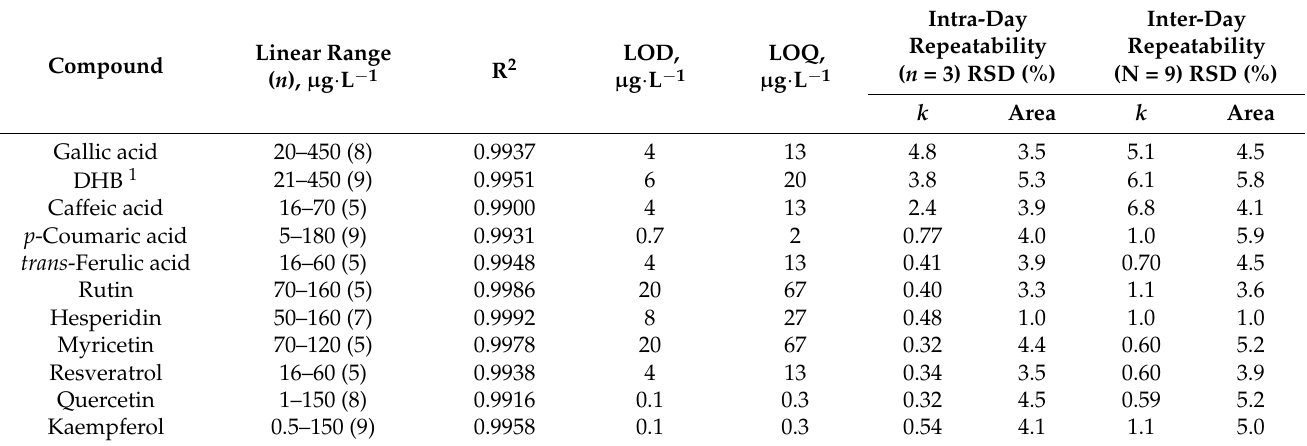
Table 2. cLC-DAD-MS calibration curves, spectral data, and wavelengths for the identification and quantification of polyphenols.